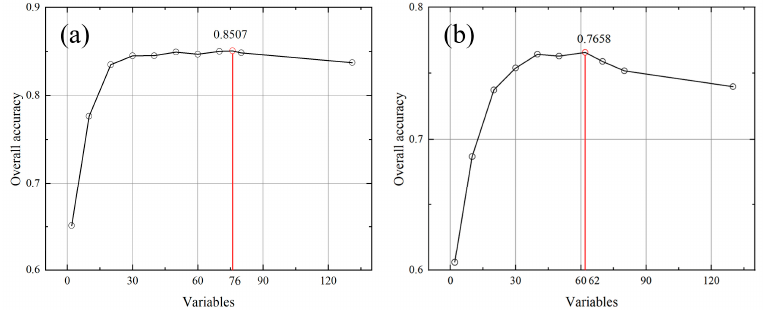
Figure 7. Change of overall accuracy with increasing number of input variables in Boruta-based variable selection (vertical red line corresponds to number of variables and overall accuracy after variable selection). ( a ) GF-1 data, ( b ) ZY-3 data.